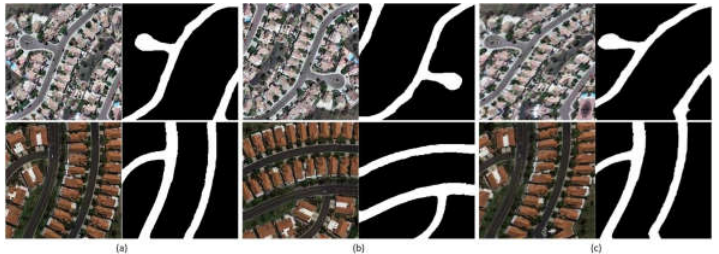
Figure 5. Morphological change methods of data augmentation: ( a ) Original image and its ground truth. ( b ) Image and its ground truth after the random flip process. ( c ) Image and its ground truth after the elastic deformations process.